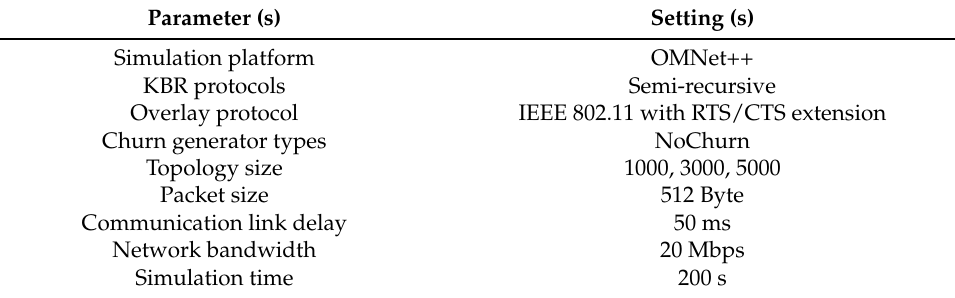
Table 4. Parameters in experiment